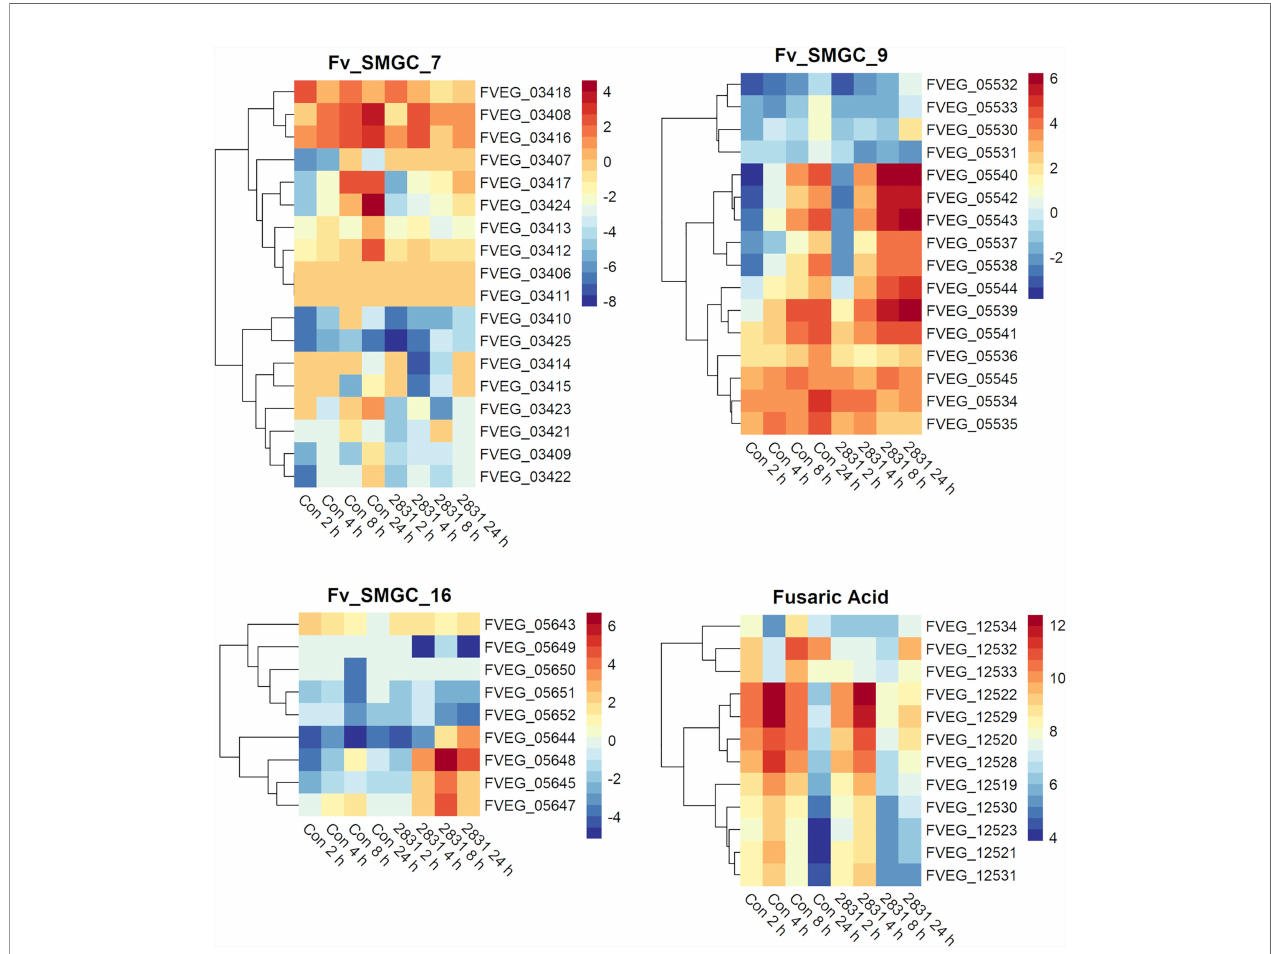
FIGURE 5 | SMGCs in response to dual-culture with Streptomyces strain s2831. Heat maps of RPKM values of SMGC 7, 9, 16, and fusaric acid clusters showing expression by F. verticillioides in response to s2831. RPKM values underwent a logarithmic transformation to be visualized by R package “ pheatmaps ” . The scale bars represent these transformed